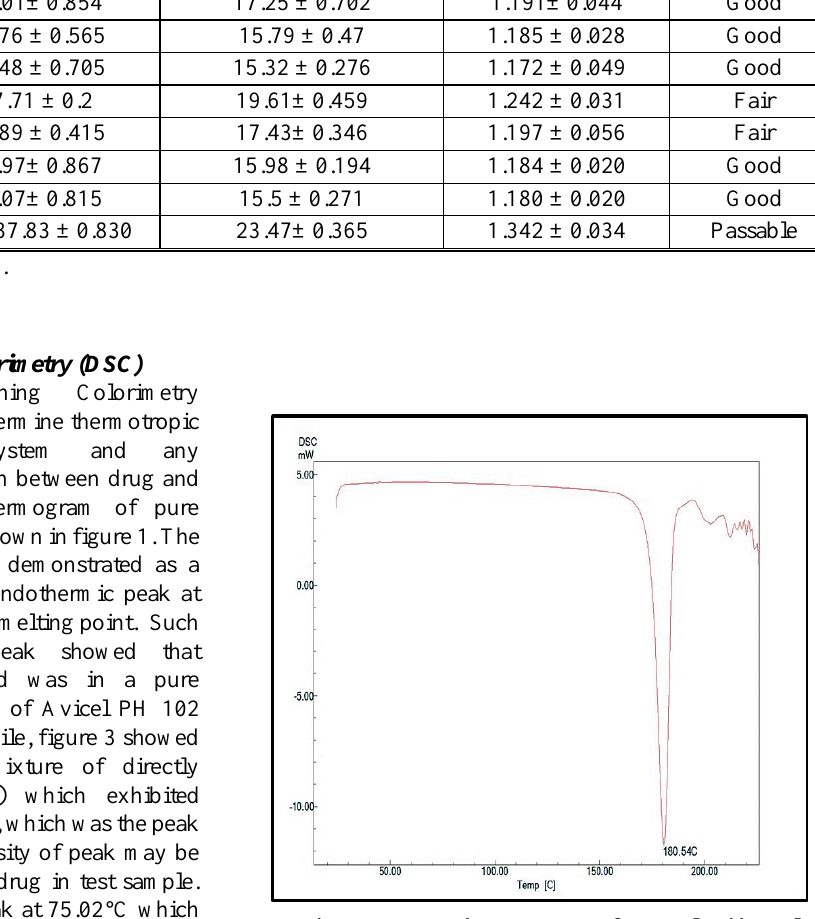
Figure 1. DSC thermogram of pure